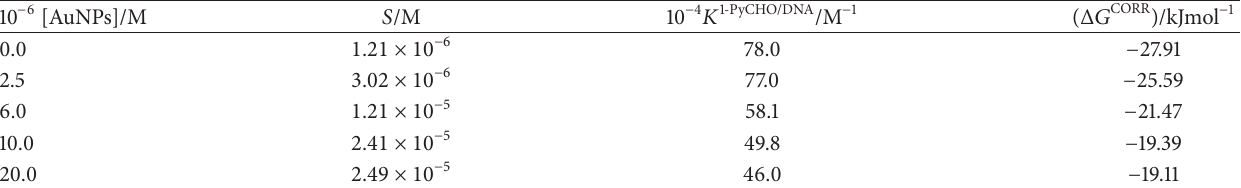
Figure 4: SEM images of CT-DNA at different concentrations of AuNPs in the presence of [NaCl] = 0.015 M. (a) [AuNPs] = 1 × 10 −6 M; (b) [DNA] = 2 × 10 −6 M; (c) [DNA] = 2.5 × 10 −6 , [AuNPs] = 2.5 × 10 −7 M; (d) [DNA] = 2 × 10 −6 M, [AuNPs] = 1 × 10 −6 M. Table 2: Solubilities ( 𝑆 ), equilibrium binding constants ( 𝐾 1-PyCHO/DNA ), and the corrected free energy (Δ𝐺 CORR ) corresponding to 1- PyCHO/DNA interaction at different Au@tiopronin concentrations.